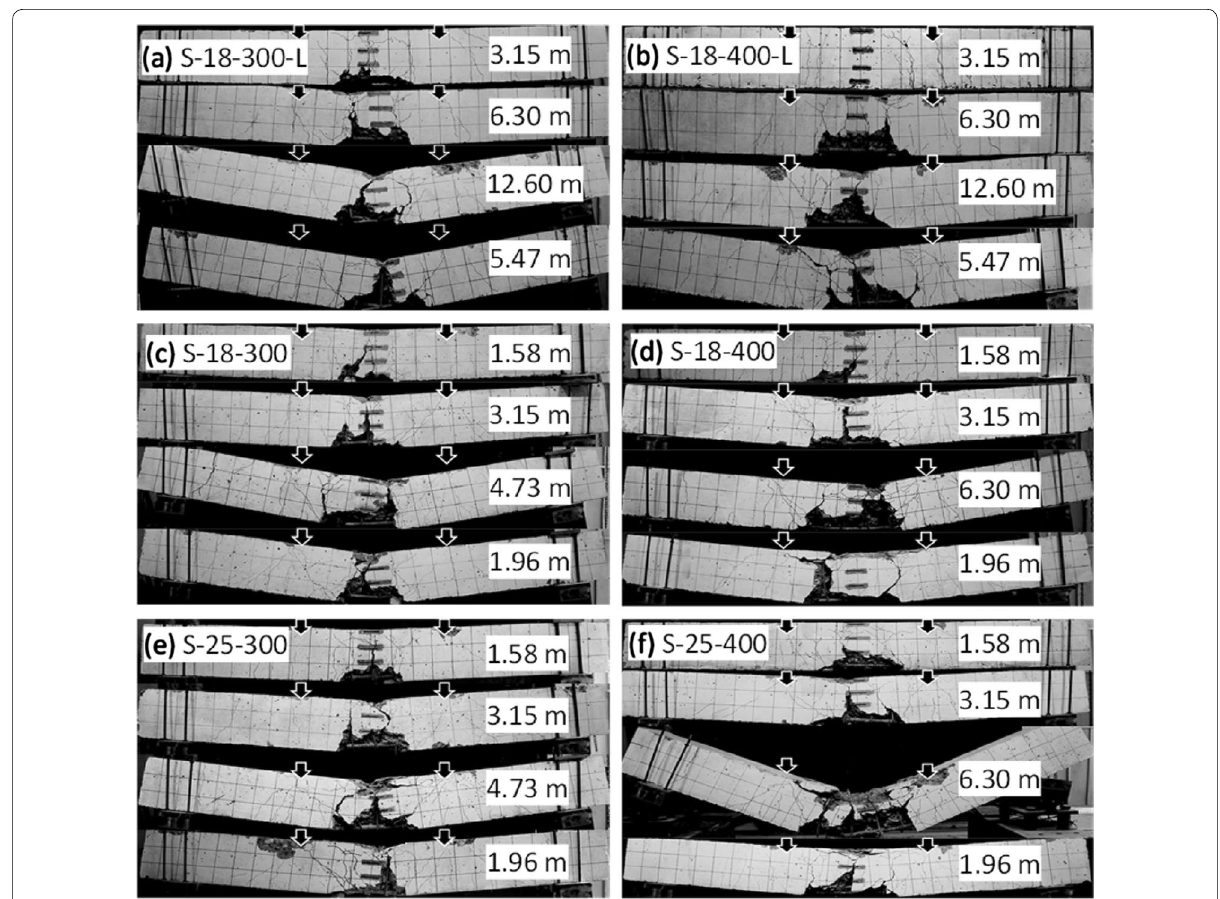
Fig. 5 Failure modes at the end of tests.